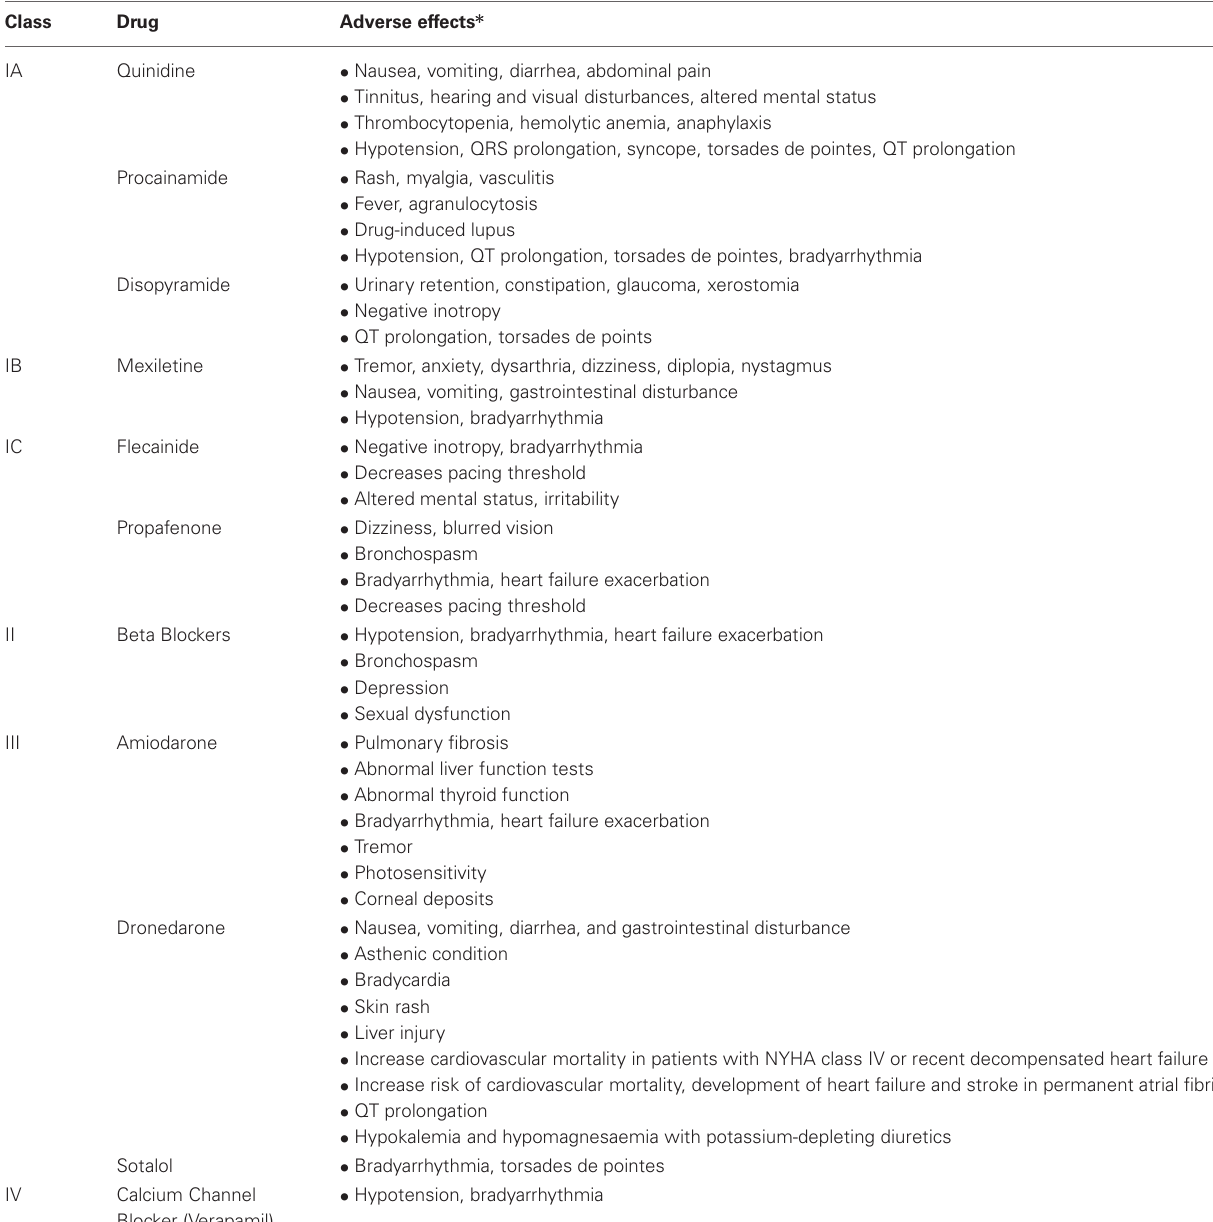
Table 1 | The most common adverse effects of frequently used antiarrhythmic drugs in the management of atrial fibrillation.